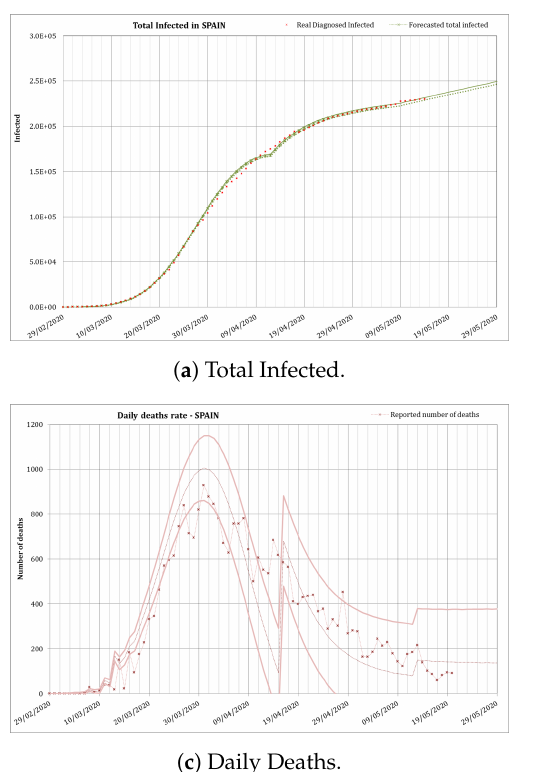
Figure 9. Total number of infected (a) , total deaths (b) and daily deaths (c) in Spain predicted from 29 February/28 June. These modelled results assumed the ease of the lock-down since the 13 April. Red dots—reported data. Green bars—modelled values with